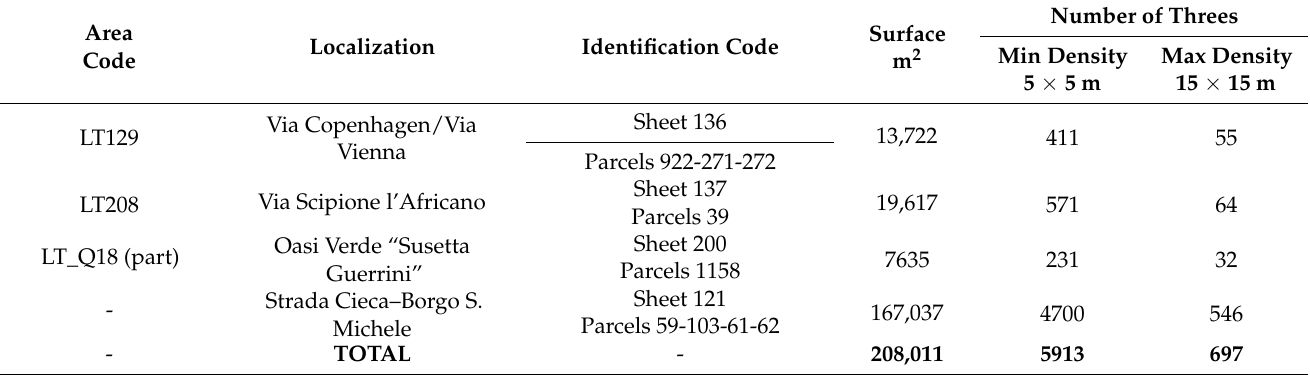
Table 9. Calculation of number and distribution of trees for the four areas of municipal property suitable for reforestation. Identification codes describe a reference system (number of sheet and parcel) on the base of which the entire national land register is organized, and they allow for the tracing of owners of the areas (the Municipality in this case) and their destination of